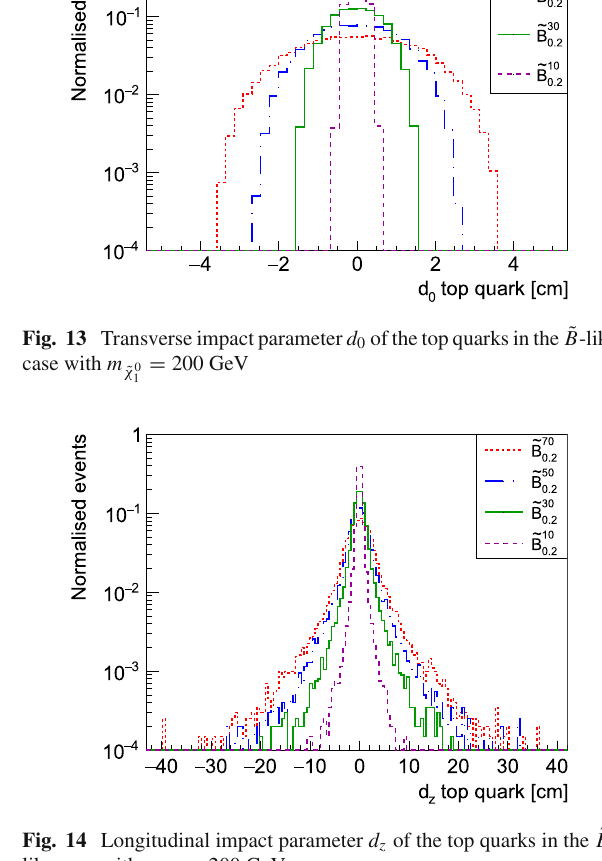
Fig. 14 Longitudinal impact parameter d z of the top quarks in the ˜ B - = 200 GeV like case with m ˜ χ 0 1